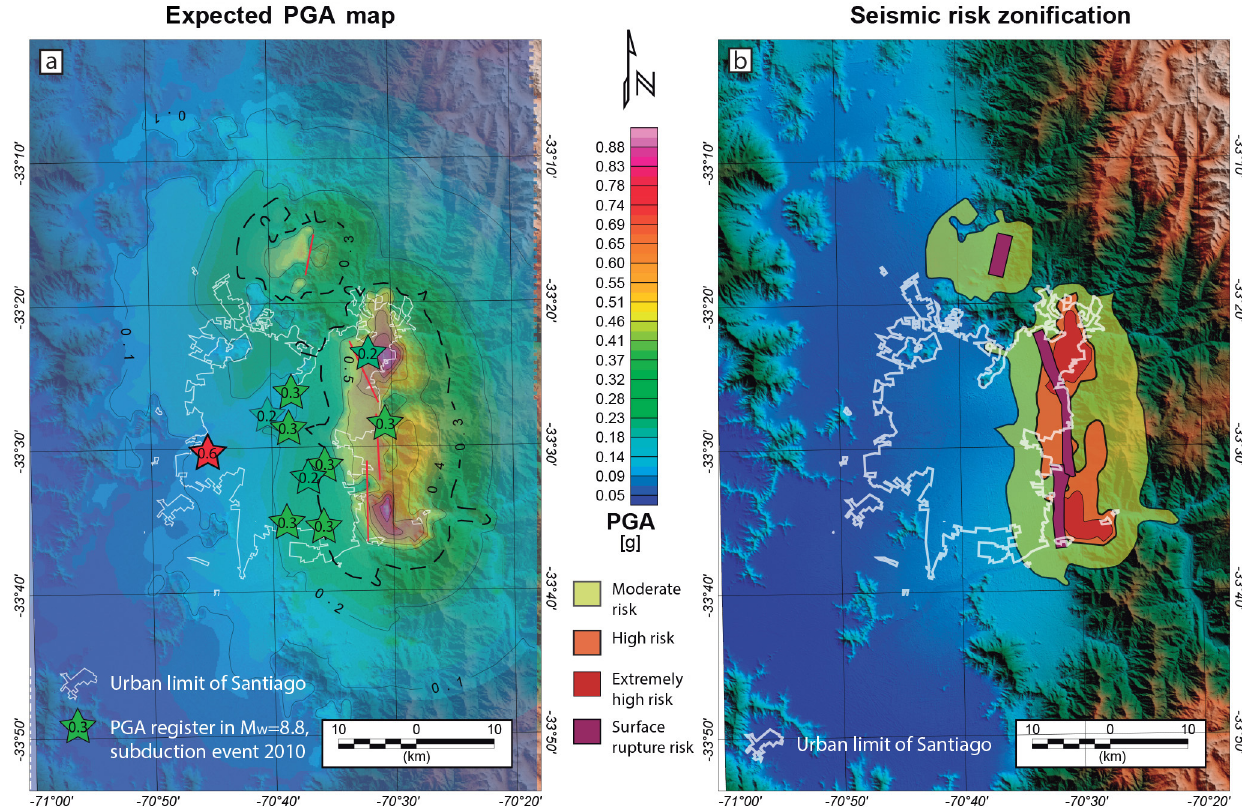
Figure 10. (a) Expected PGA map of the largest acceleration of each point taking into account the four probable rupture scenarios. The stars represent the PGA recorded for the 2010 Maule event ( M w = 8.8) (Barrientos, 2010) in the same color scale. (b) Seismic risk zoning: in yellow the area with acceleration greater than 0.3g, which is the design PGA estimate by the Chilean norm is shown. In orange the area with more than 0.4g is shown. In red the hanging wall filled with sediments that concentrate the greatest PGA>0.5g is shown. In purple the zone with a possible surface rupture, based on the basement scarps identified in gravity profiles is